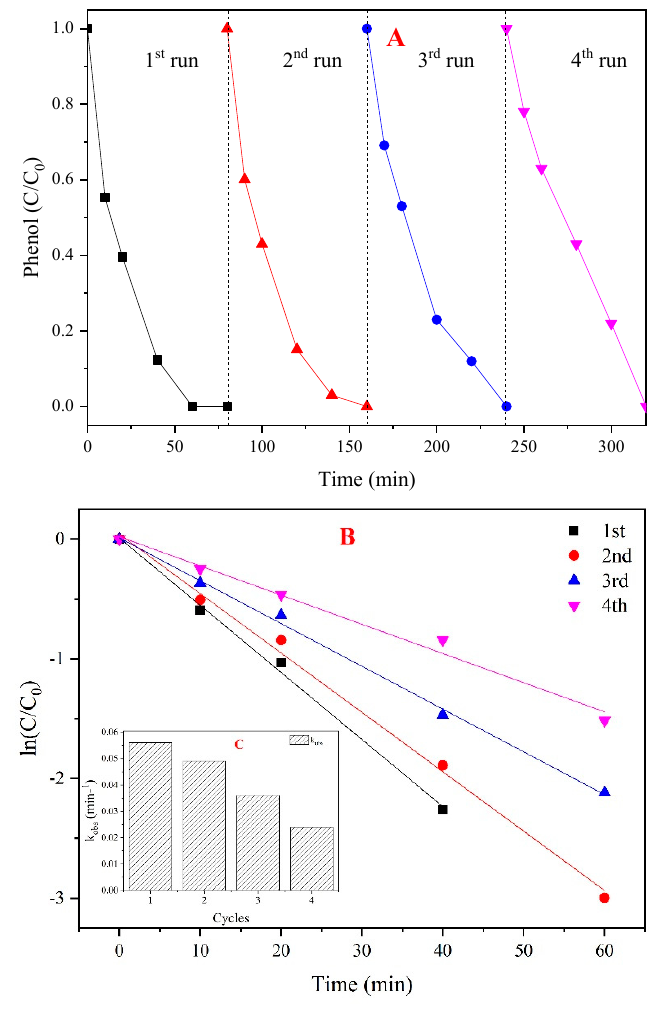
Figure 7. ( A ) Influence of different initial pHs of the PMS/CoMgAl-LDH system during the degradation of phenol; ( B ) comparison of absence and presence of CoMgAl-LDH with PMS removal of phenol.